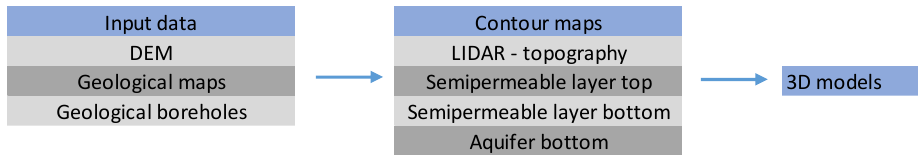
Figure 2. Methodological chart showing the required data and steps for developing 3D models.